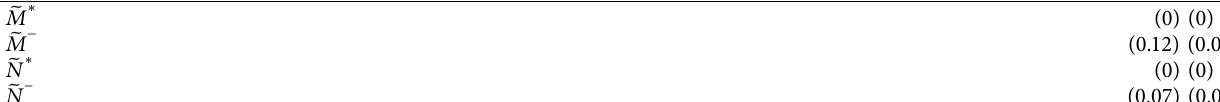
Table 13: 􏽥 M ∗ , 􏽥 M − , 􏽥 N ∗ , and 􏽥 N − .